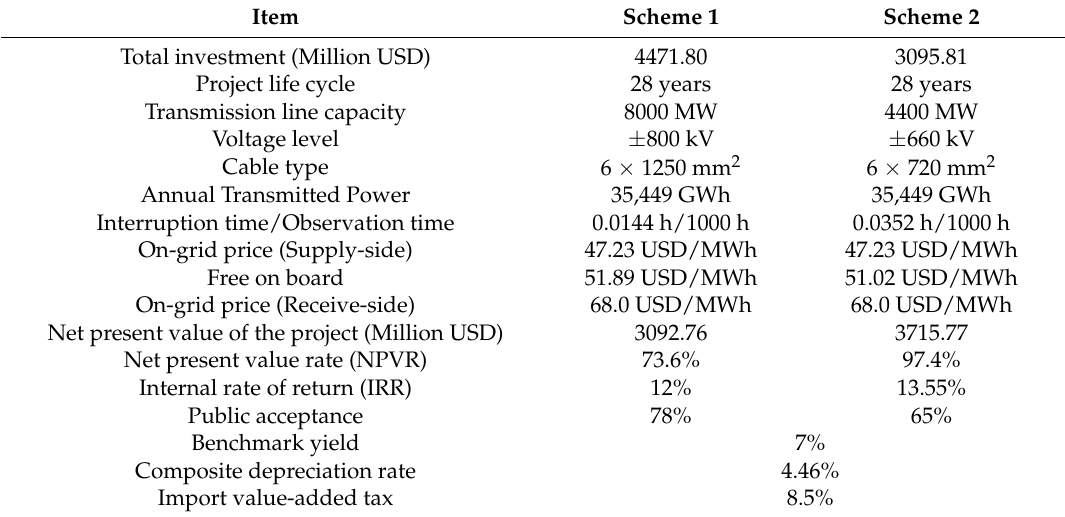
Table 8. The basic information of two different investment schemes.